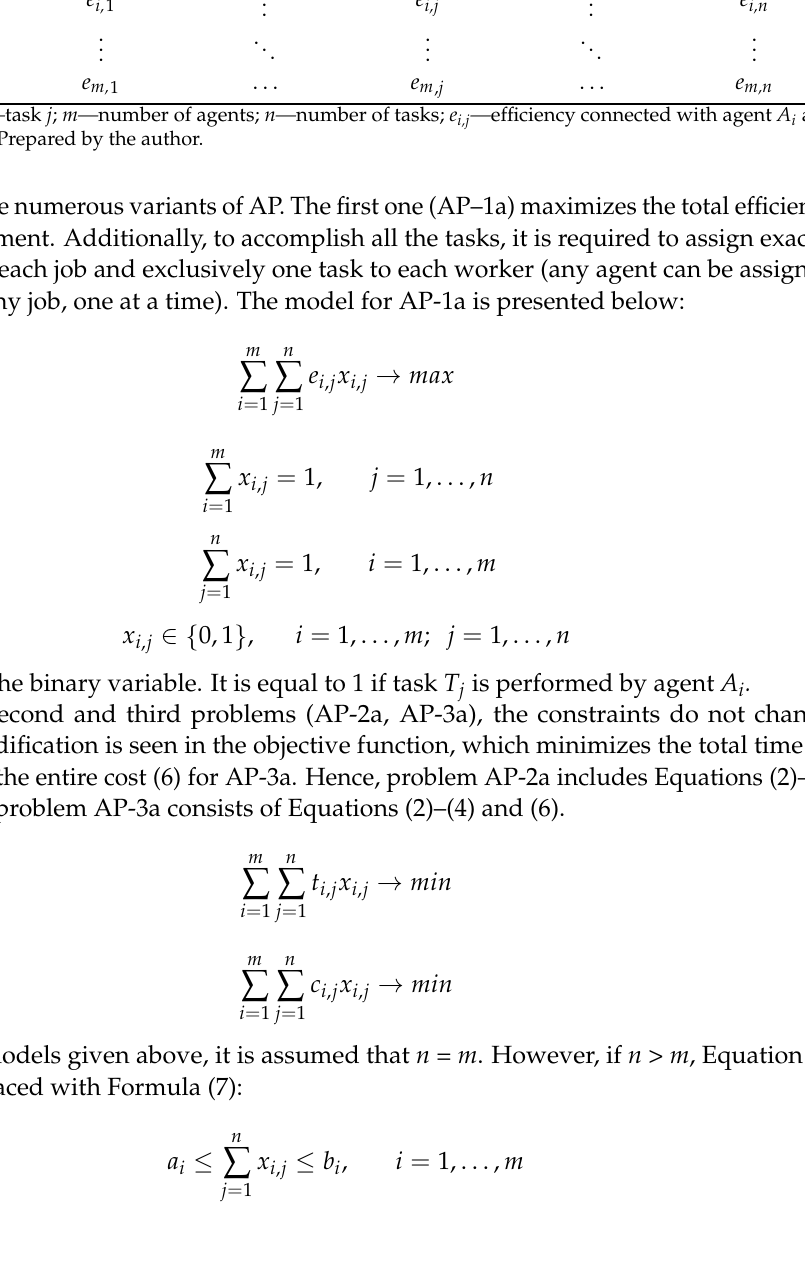
Table 1. The assignment problem with efficiency parameters. Task Agent T 1 . . . T j . . . T n A 1 e 1,1 . . . e 1, j . . . e 1, n . . . . ... . . ... . . . . . . . . . . A i e i, 1 . e i,j . e